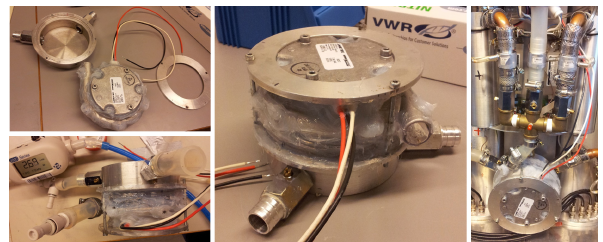
Figure 15. Procedure for replacing a blower for a 1-blower instru-